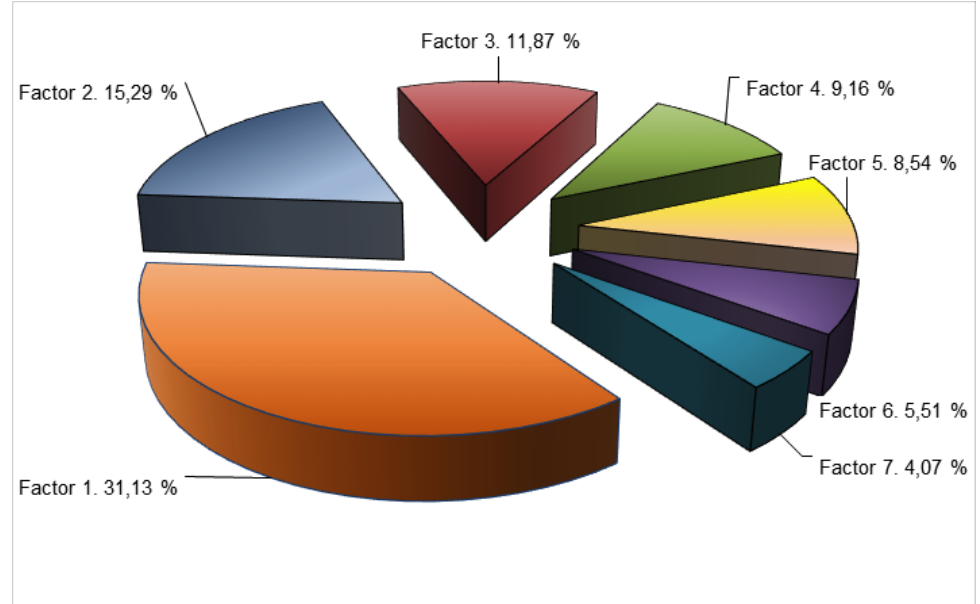
Fig. 2. Key factors of highly skilled wrestler functional fitness: 1 – general level of FF; 2 - cardiovascular system functional state in basal conditions; 3 – power of anaerobic energy supply system; 4 – efficiency of aerobic energy supply mechanism; 5 - state of regulatory mechanisms of cardiac function; 6 – cardiac muscle excitability; 7 – cardiac muscle metabolism.